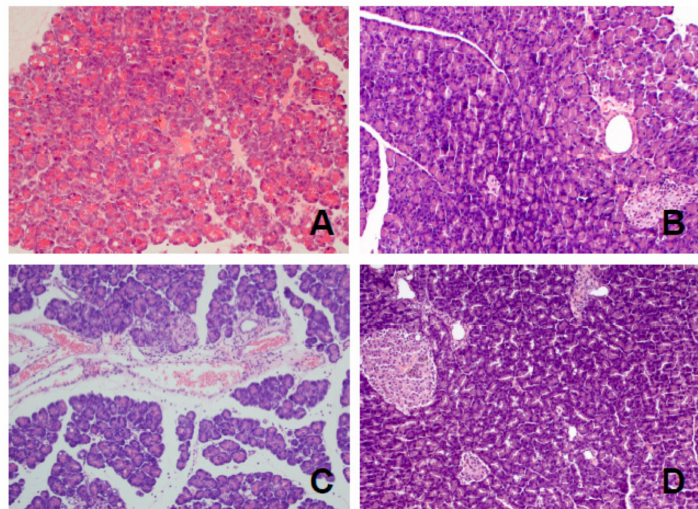
Figure 1. Representative morphological features of the pancreas observed after 14 day pancreatic reperfusion in the course of ischemia / reperfusion-induced acute pancreatitis. ( A ) Rats treated with saline; ( B ) rats treated with acenocoumarol given at a dose of 50 µ g / kg / day; ( C ) rats treated with acenocoumarol given at a dose of 100 µ g / kg / day; ( D ) rats treated with acenocoumarol given at a dose of 150 µ g / kg / day. Hematoxylin-eosin counterstain. Original magnification 200 ×